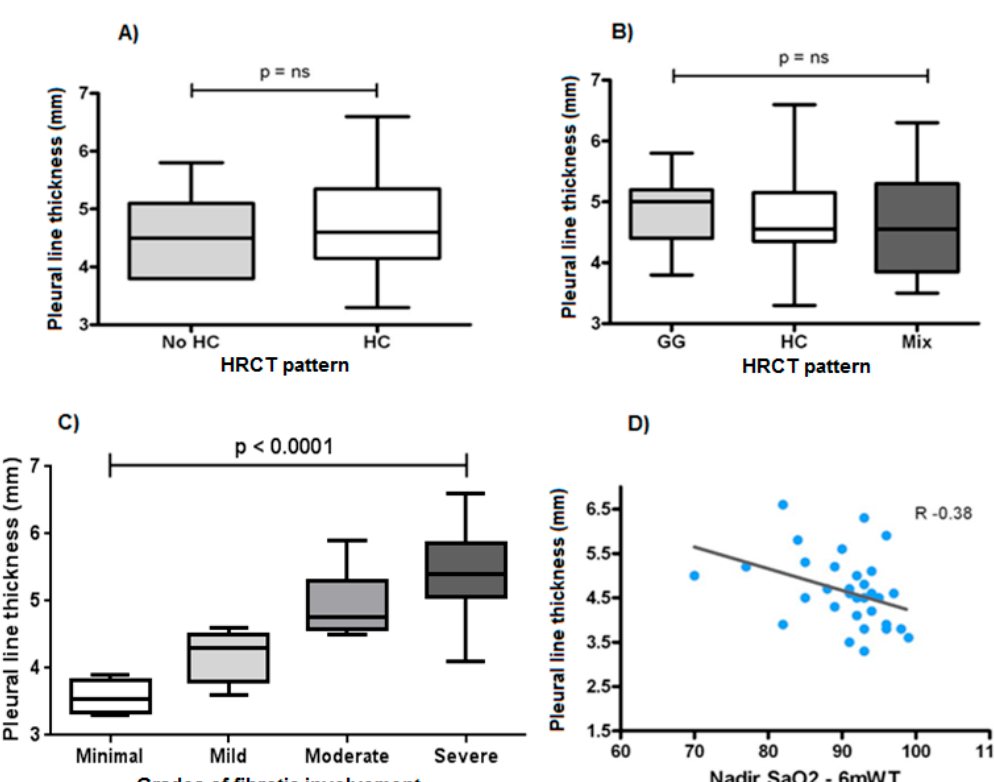
Figure 1. ( A ) Thickness of the hyperechoic pleural line between honeycombing (HC) and no honeycombing (no HC) HRCT pattern ( p > 0.05). ( B ) Thickness of the hyperechoic pleural line between different HRCT patterns (GG: ground glass, HB: honeycombing, Mix: mixed patterns) ( p > 0.05). ( C ) Thickness of the hyperechoic pleural line between patients with different grades of fibrotic involvement ( p < 0.0001). ( D ) Correlation between the thickness of the hyperechoic pleural line and the Nadir value of SaO 2 % reached during 6-min walking test (6mWT) ( r − 0.38).